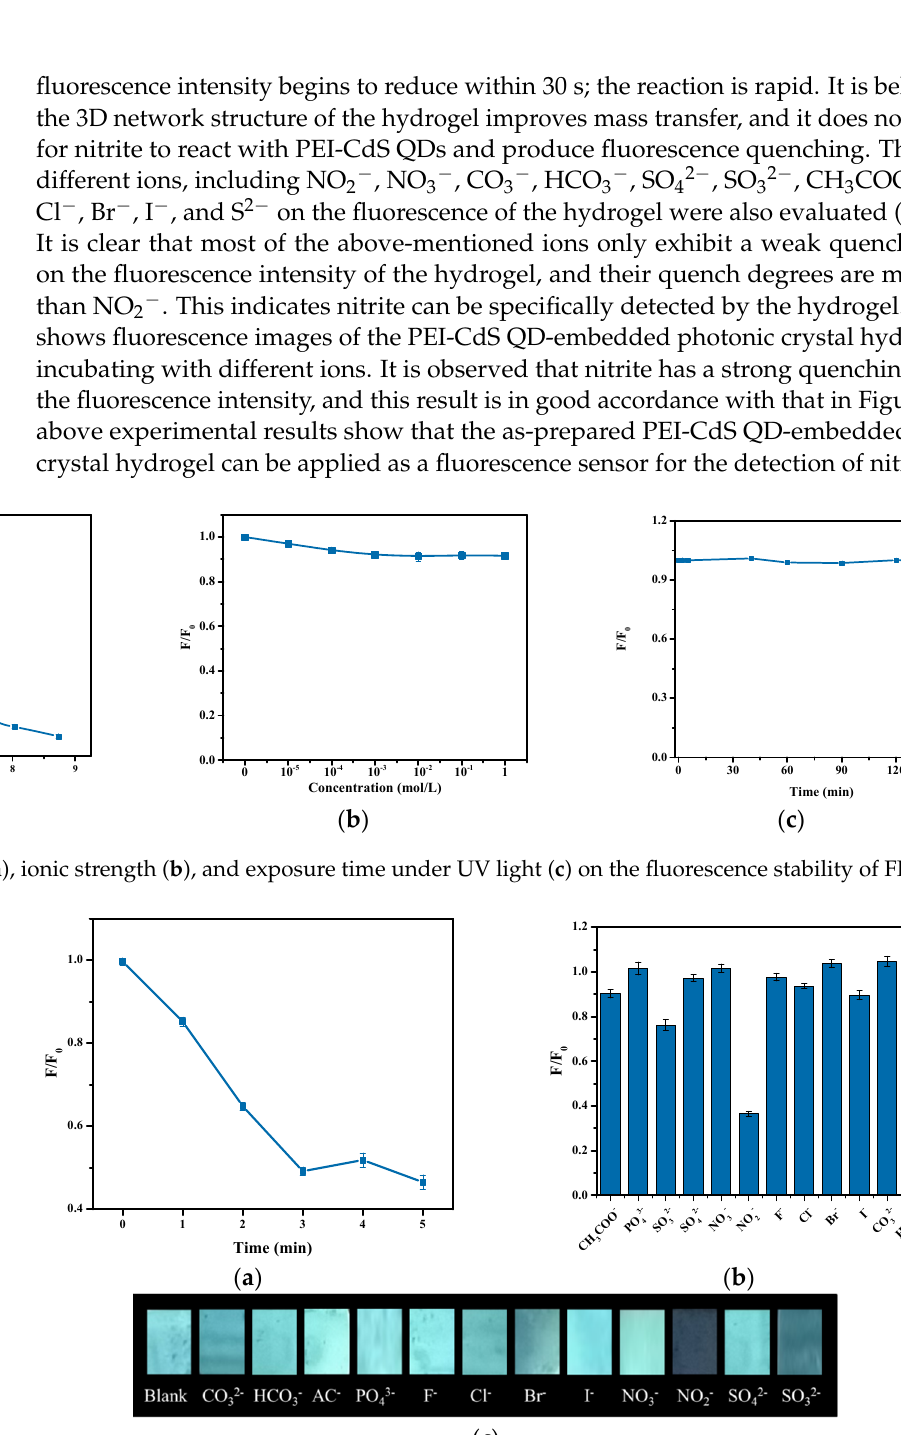
Figure 6. Effect of pH ( a ), ionic strength ( b ), and exposure time under UV light ( c ) on the fluorescence stability of FHF 470.